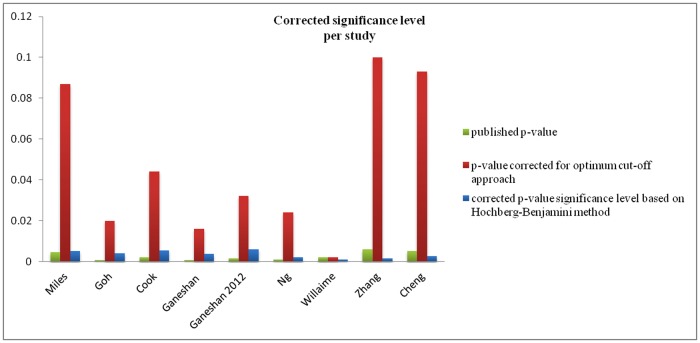
Studies from categories A and B after adjustments for optimum cut-off approach and/or multiple hypotheses testing.Green column demonstrates the smallest published p-value per study, the red the Pcor for the optimum cut-off approach, and the blue the corrected statistical significance level based on Hochberg-Benjamini method. For a study to have a statistical significant result the red column value should be smaller than the green blue which is not the case for any of them. For study [19] the green and red column are identical as investigators did not use the optimum cut-off approach. Studies [31,33] and [41] were excluded as they did not provide a summary of their p-values for correction, and had adjusted the results for multiple hypotheses, respectively.